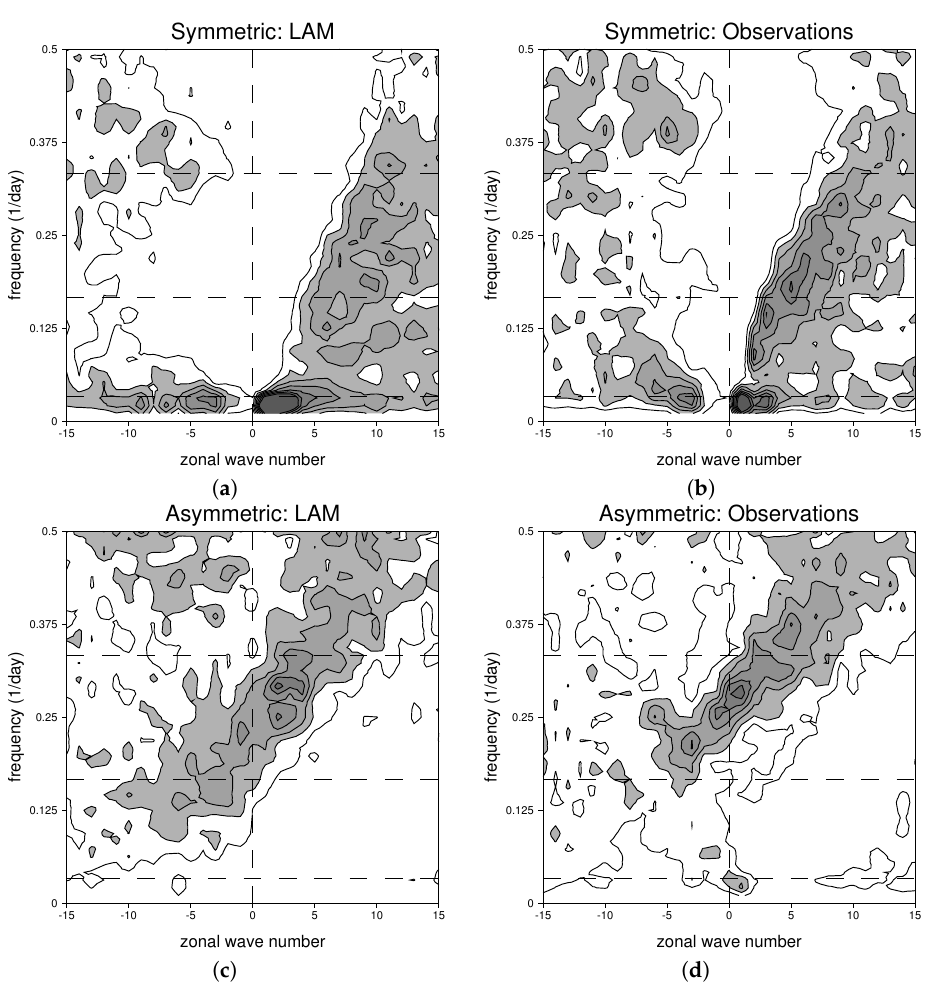
Figure 4. ( a , c ) simulated and ( b , d ) observed wavenumber frequency spectra, each divided by a smoothed background spectra (following